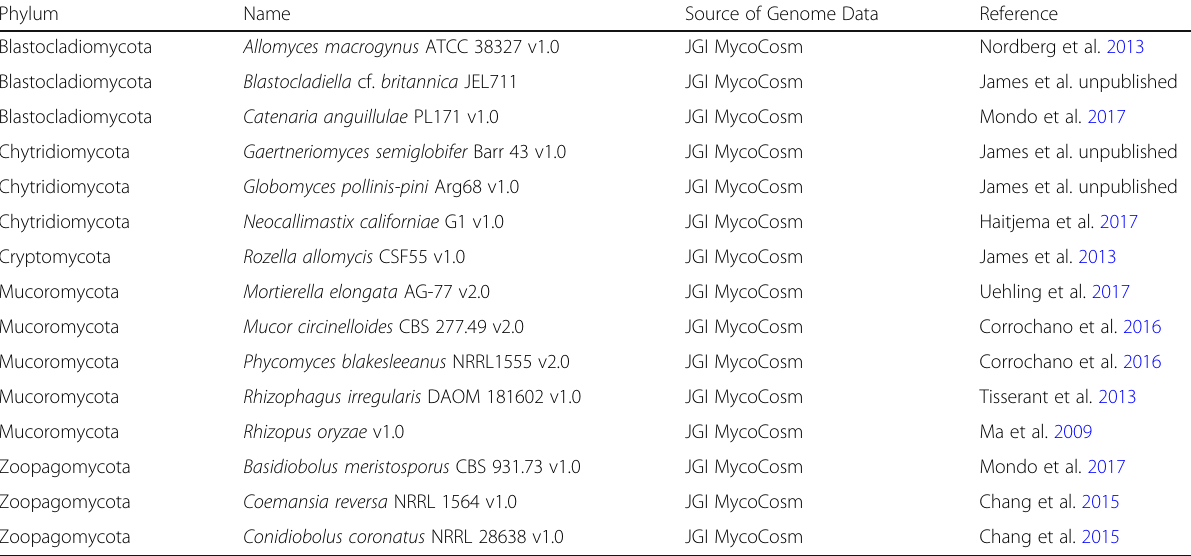
Table 2 List of genomes used for phylogenetic analysis in current study